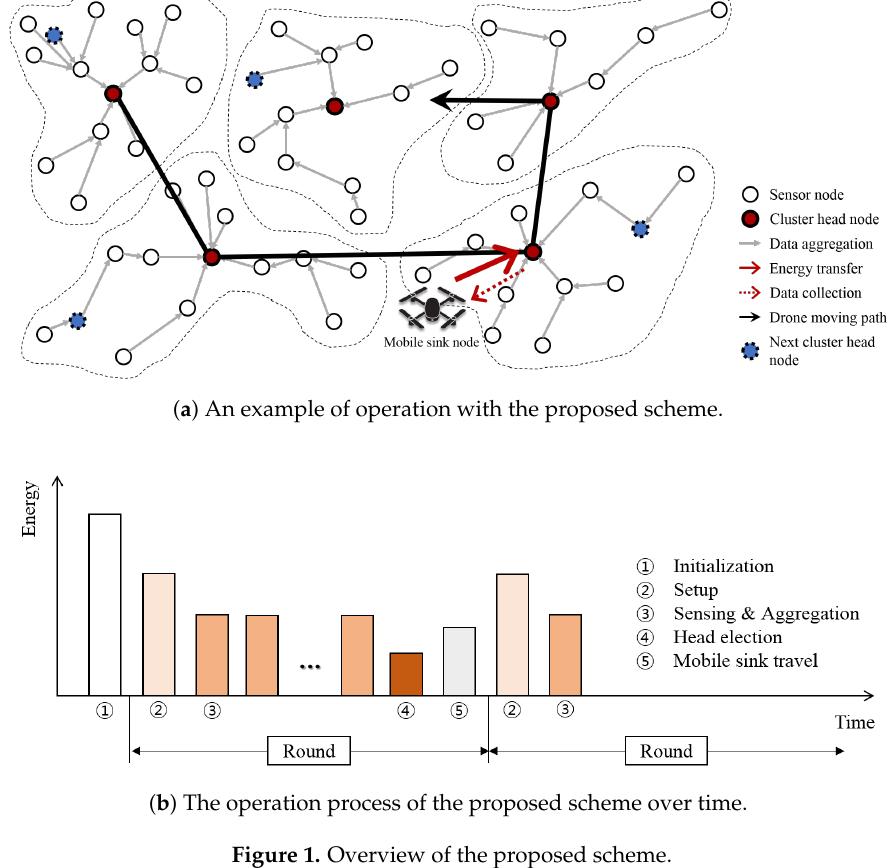
Figure 1. Overview of the proposed